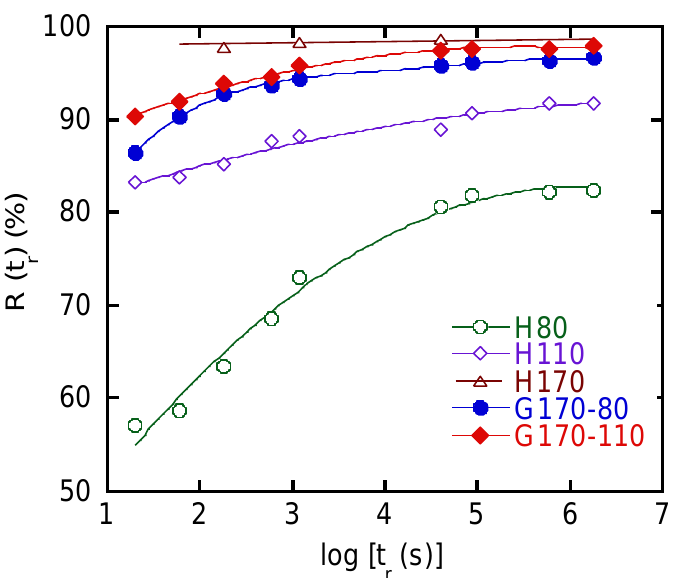
Figure 7. Recovery ratio R ( t r ) as a function of time after stress removal.